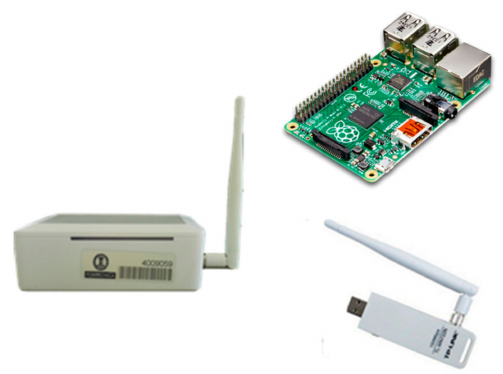
Figure 4. Listening device used in the people flow monitoring sensor network.